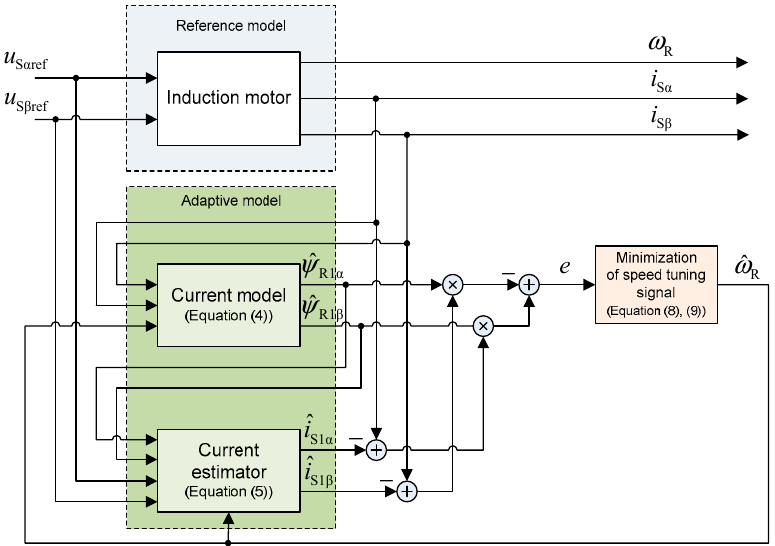
Figure 2. Current-based MRAS observer used for speed sensor fault-tolerant control.